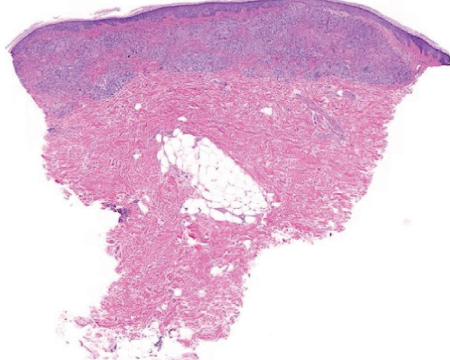
Figure 3: H&E-stained biopsy specimen at 10x magnifcation.